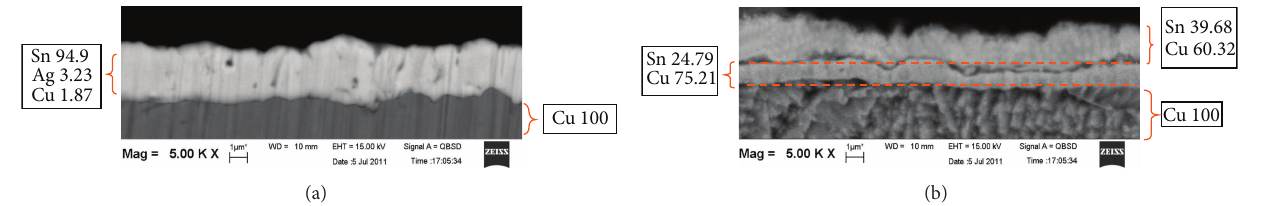
Figure 7: FESEM micrographs of the cross-sectional surface of (a) as-deposited SAC305 thin film and (b) as-reflowed SAC305/Cu at 230 ∘ C for 30s.